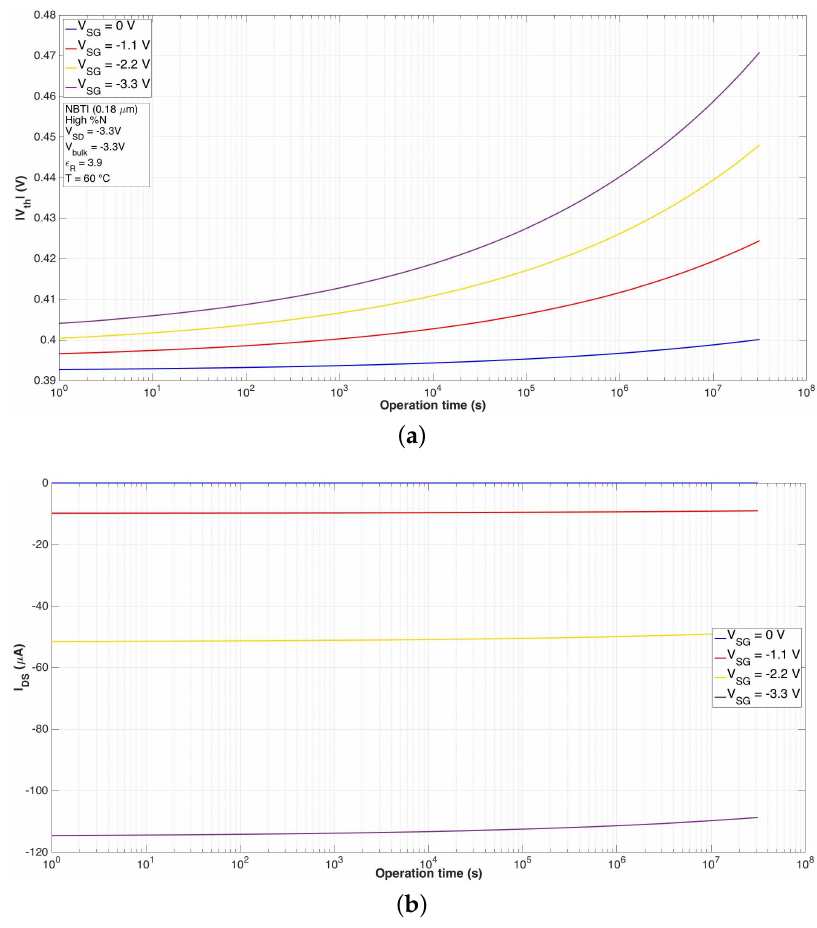
Figure 18. Results for the simulation of BTI in I-V curves, ( a ) threshold voltage, and ( b ) drain current degradation for one year of continuous operation, for a pMOS device with high nitrogen content in the gate